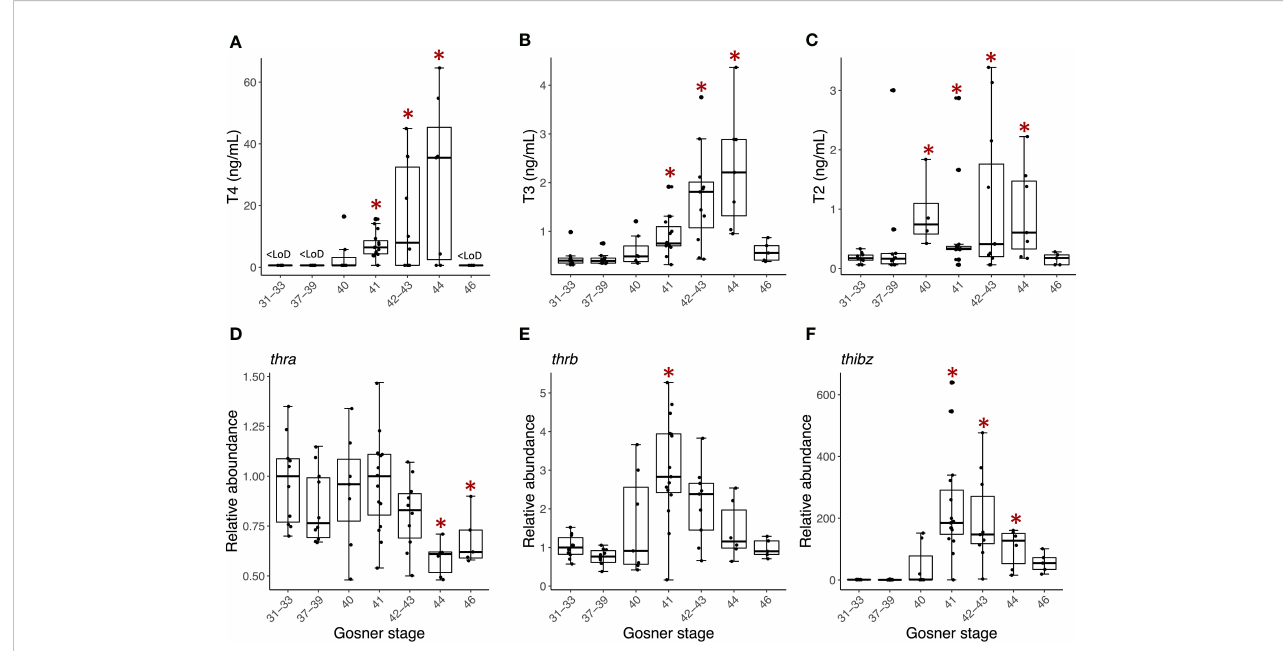
FIGURE 1 Box plots showing serum concentration (ng/mL) of (A) T4, (B) T3, and (C) T2 and back skin gene expression of (D) thra, (E) thrb, and (F) thibz for the grouped Gosner stages. The lower and upper hinges correspond to the fi rst and third quartiles. The whiskers extend from the hinge to the largest/ smallest value no further than 1.5 times the inter-quartile range. Circles show individual replicates. Asterisks indicate signi fi cant difference from the premetamorphic Gosner stage 31-33 (Dunn ’ s post hoc test, p-value